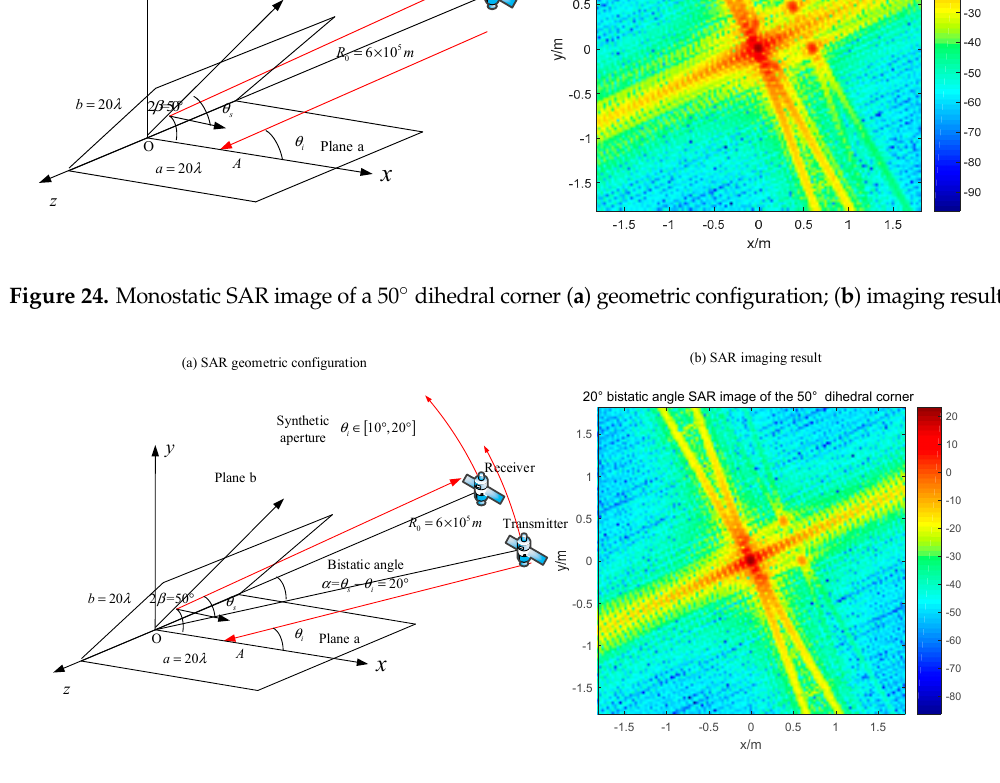
Figure 24. Monostatic SAR image of a 50° dihedral corner ( a ) geometric configuration; ( b ) imaging result.